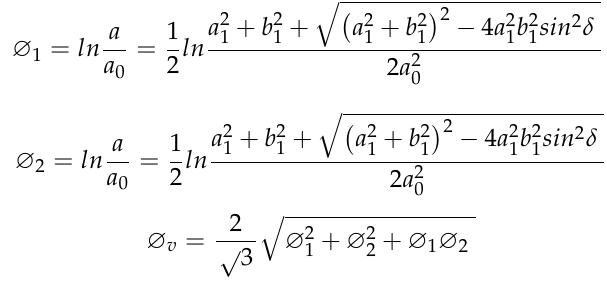
Figure A6. Account length of the selected area used to calculate mesoscale plane-strain for the tensile specimen (11K).